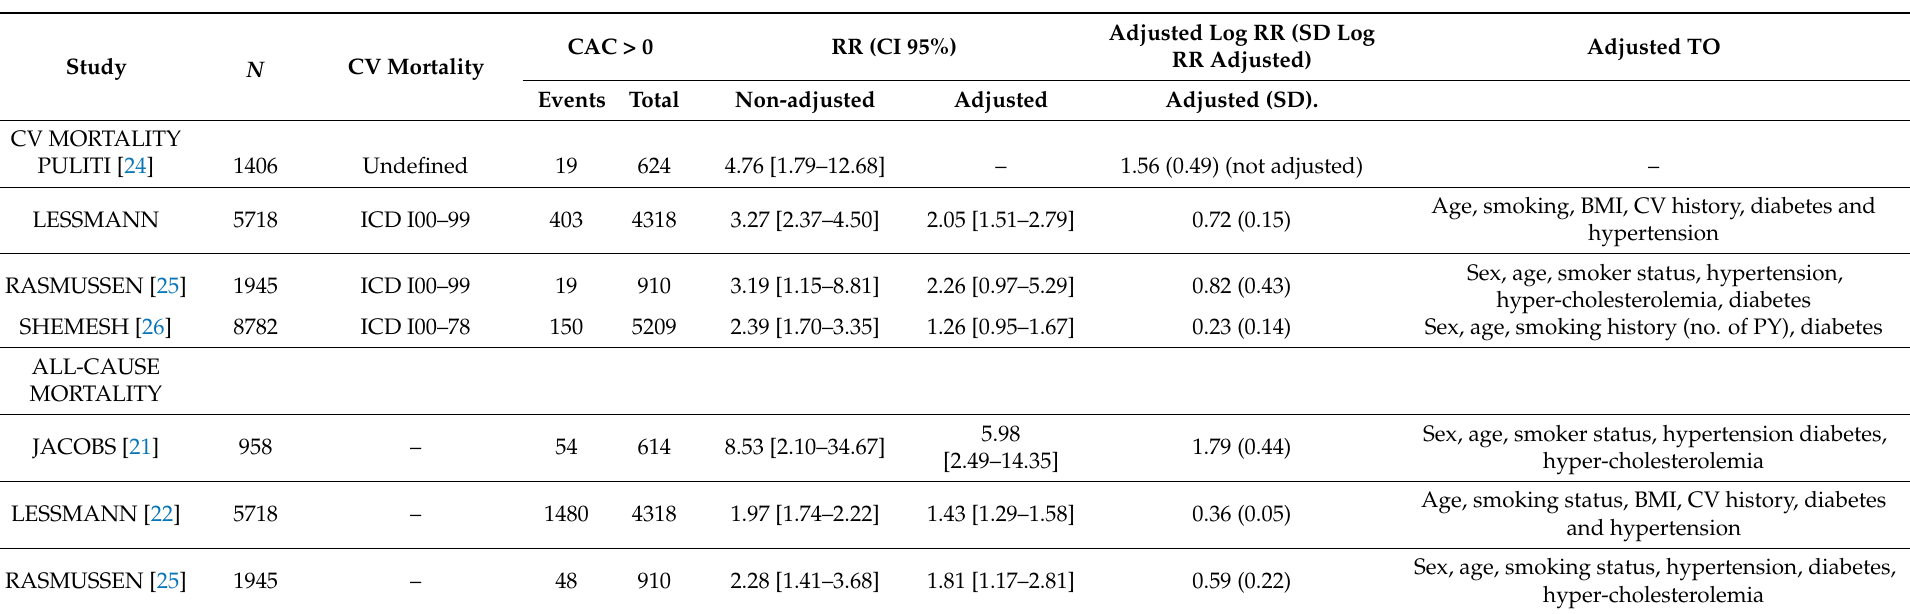
Table 2. Cardiovascular (CV) or global mortality according to coronary artery calcification (CAC)